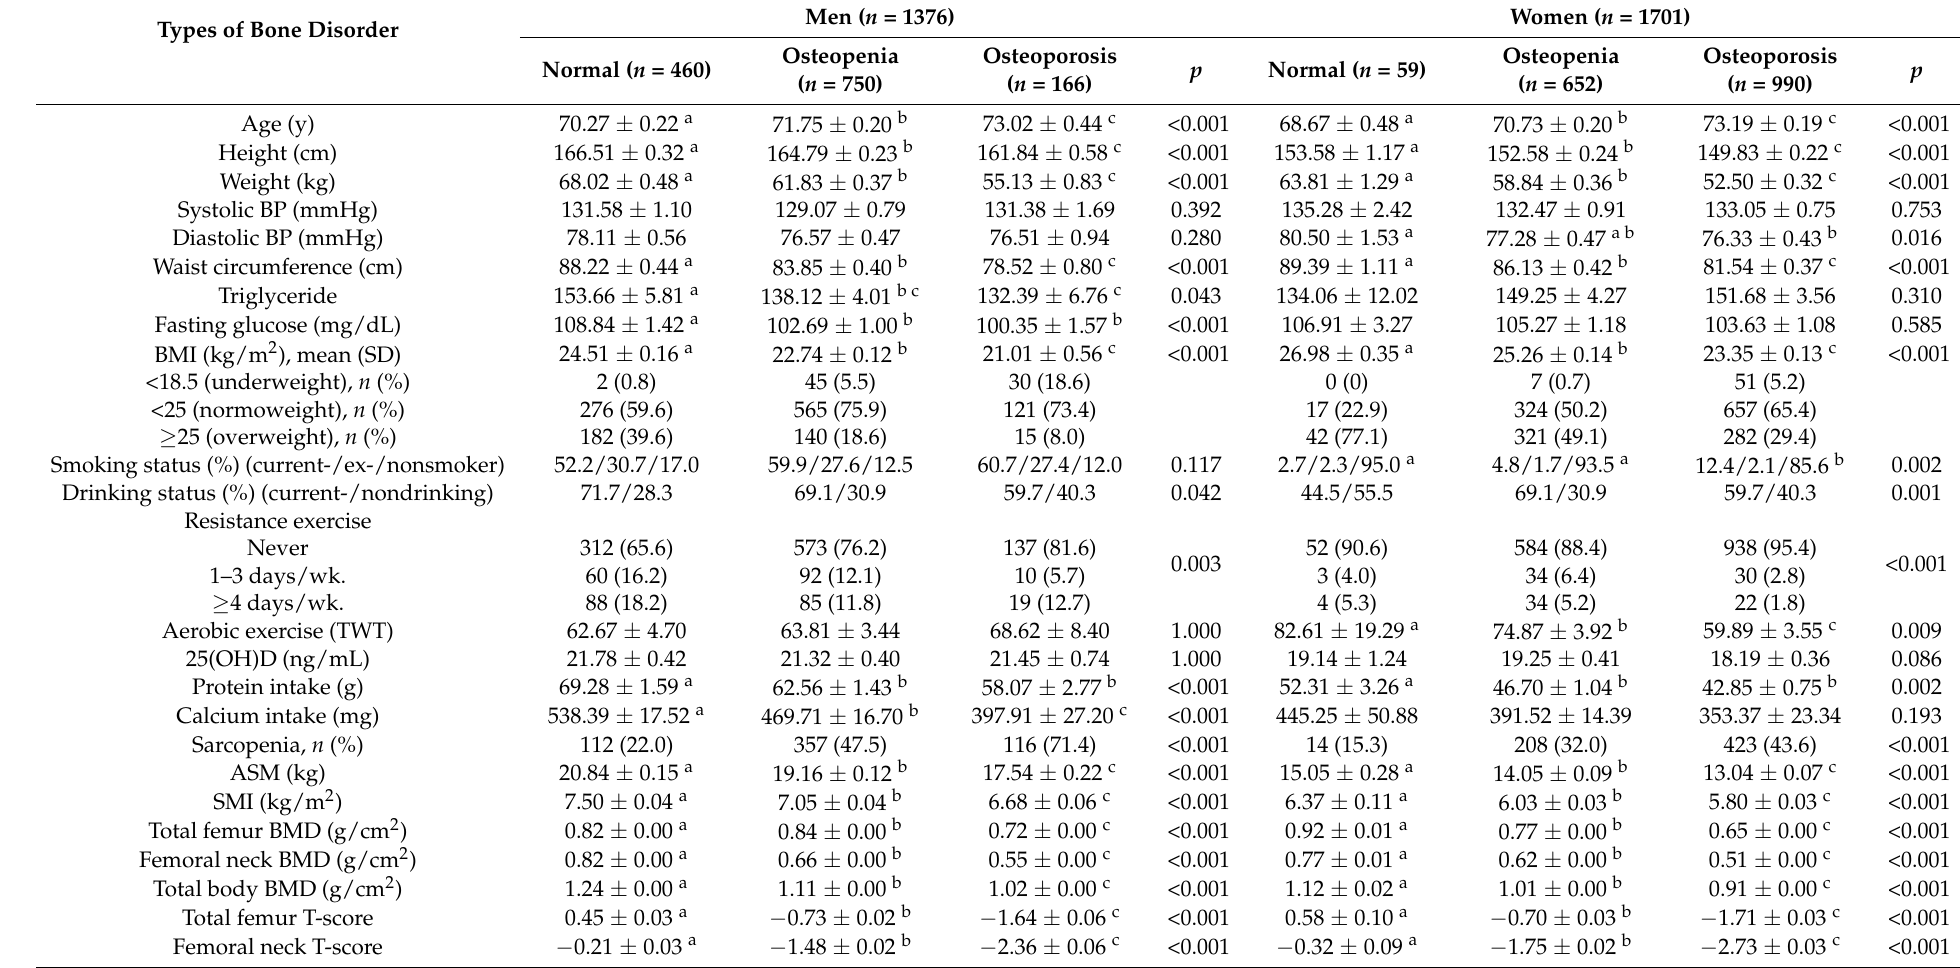
Table 3. Characteristics of participants stratified by sex according to bone